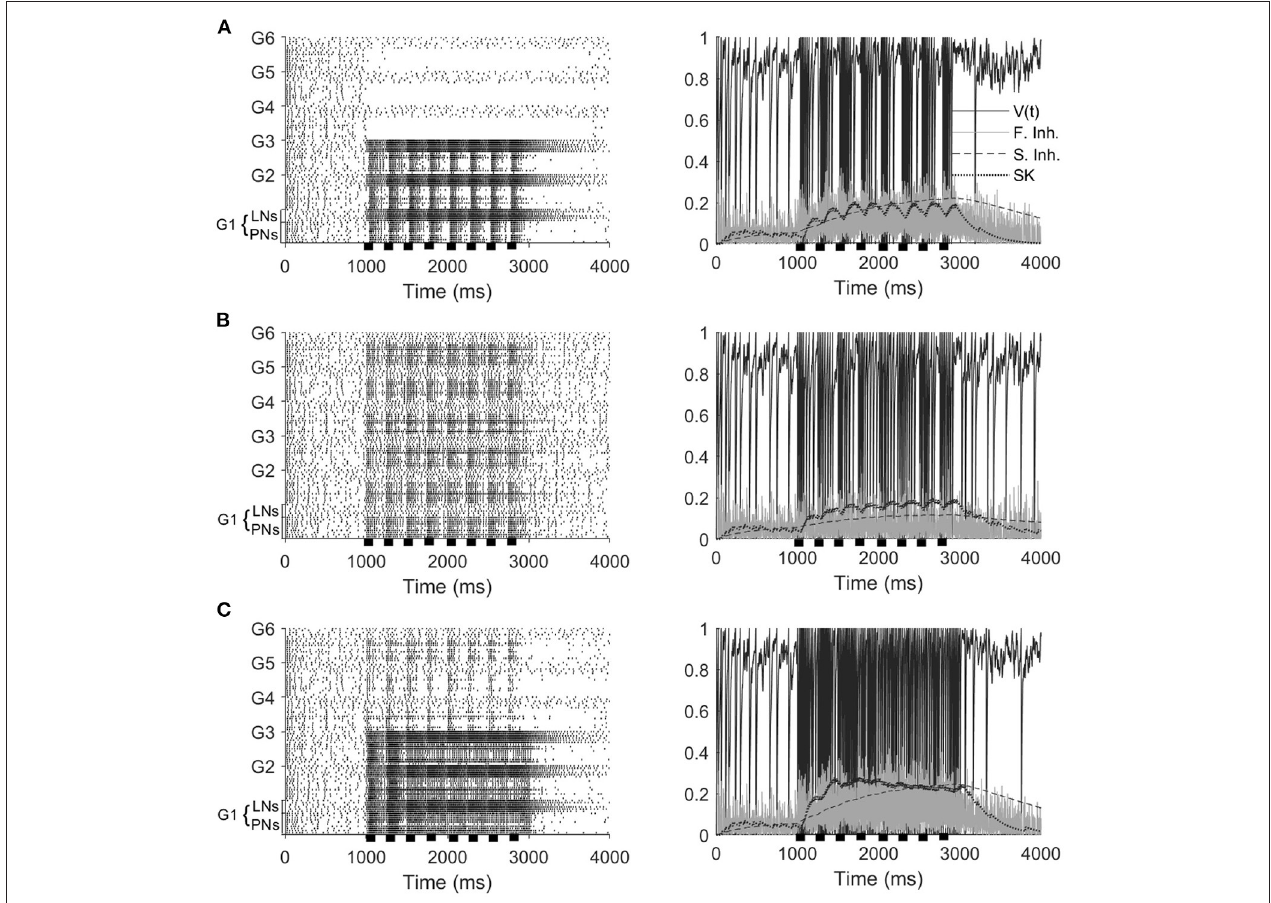
FIGURE 2 | Model responses to 4 Hz stimulus pulses in the odor only (A) , mechanosensory only (B) , and additive sensory integration (C) stimulus scenarios. Odor is simulated by sending stimulus current to only glomeruli 1, 2, and 3, while mechansensory input is simulated by sending stimulus current to all glomeruli. Left panels show spike rasters for the entire network, while right panels show the membrane potential, fast inhibitory current, slow inhibitory current, and SK current for a representative PN within the network (in the presence of odor stimulus, the PN is taken from a glomerulus receiving odor input). Stimulus pulses are 50 ms in length. Black bars indicate